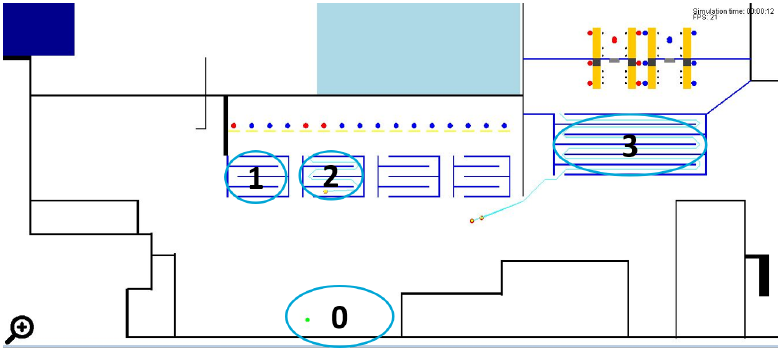
Figure 1. Airport layout of the open publicly accessible areas considered in this case study, with indicators for different targets. 0: Entrance area, 1 and 2: Check-in areas, 3: Security checkpoint area. For the full airport layout, refer to